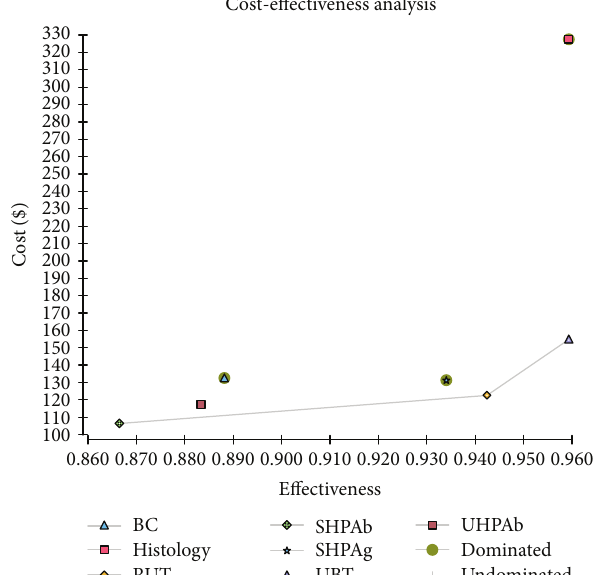
Figure 2: Cost-e ff ectiveness graph. Cost-e ff ectiveness analysis showed that histology, stool H. pylori antigen, and bacterial culture were absolutely and urine H. pylori antibody was weakly dominated by serum H. pylori IgG antibody, rapid urease test, and urea breath